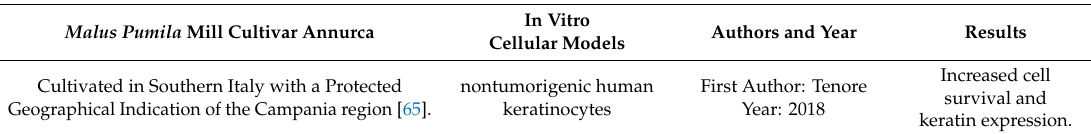
Table 2. Schematic representation of in vitro cellular models used to test the e ff ects of Malus pumila Mill cultivar Annurca. Malus Pumila Mill Cultivar Annurca